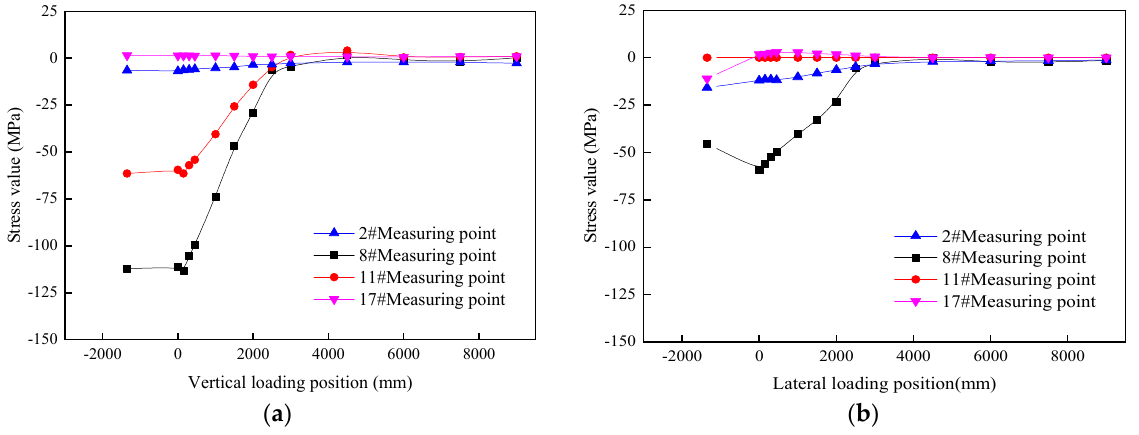
Figure 15. Longitudinal loading 105# Diaphragm (notch optimization) CI area measuring point stress-load position relationship curve: ( a ) Before optimization, ( b ) after optimization.